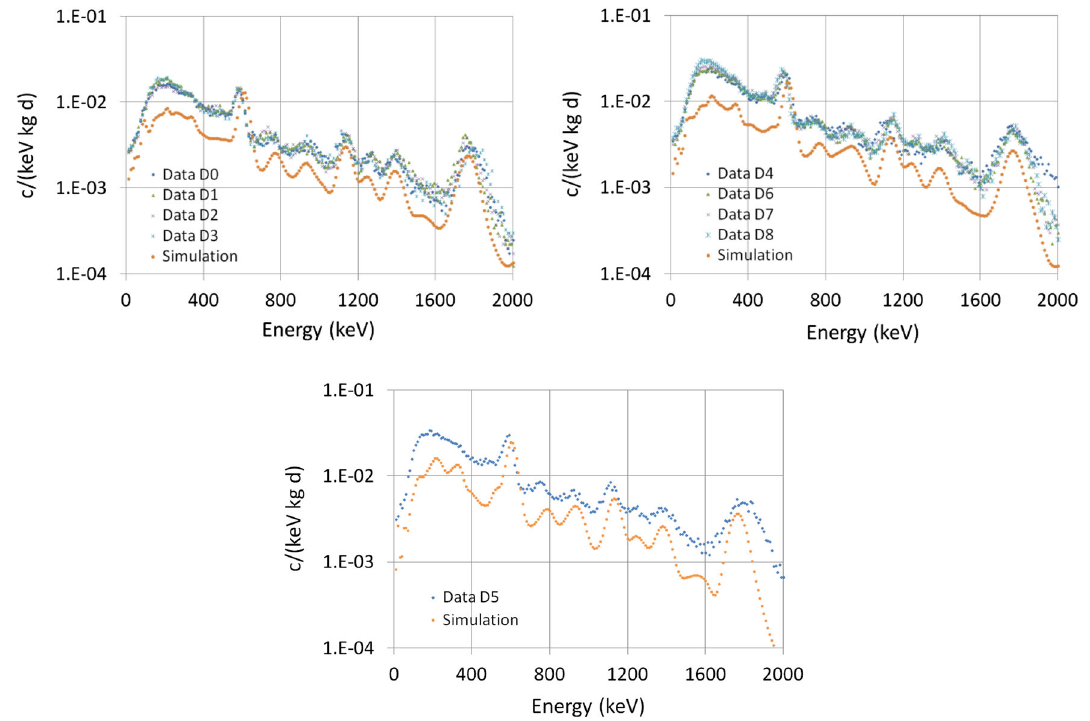
Fig. 13 Energyspectrainthedetectorhavinganeventcompatiblewith NaI scintillation for the selected coincidence events with a very low energy anomalous event (rejected by the filtering procedure) in another onedetectorcomingsupposedlyfromPMTradioactivecontaminations.